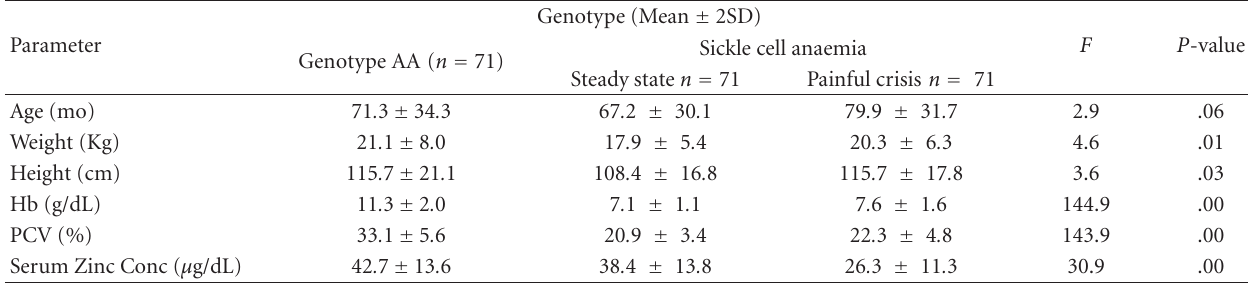
Table 1: Mean haematological parameters and serum zinc concentration in Cases and